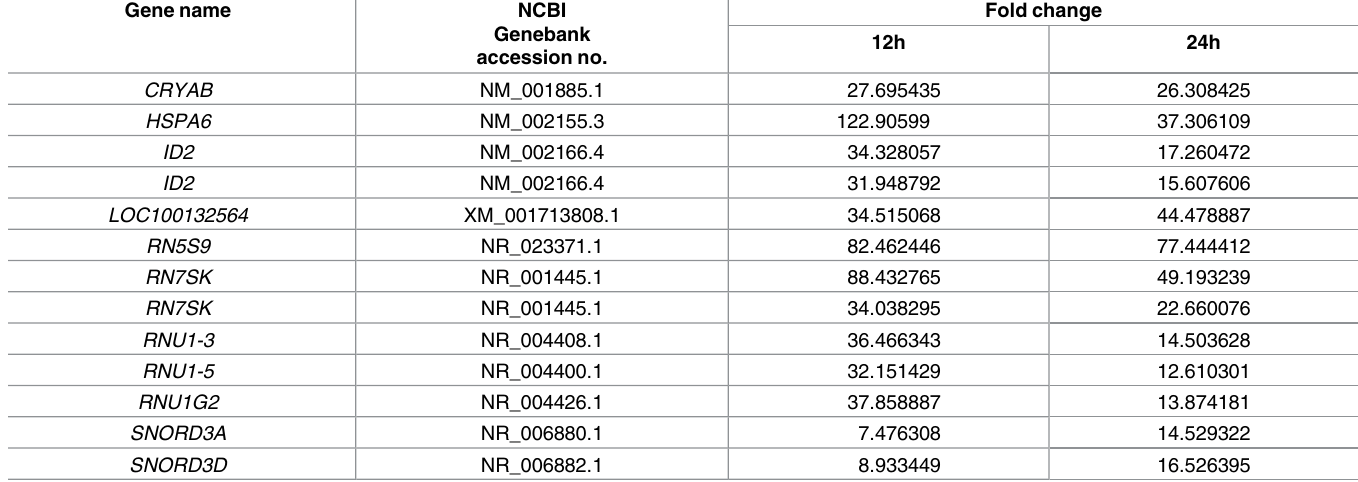
Table 5. Up-regulated genes following GE treatment (800 μ